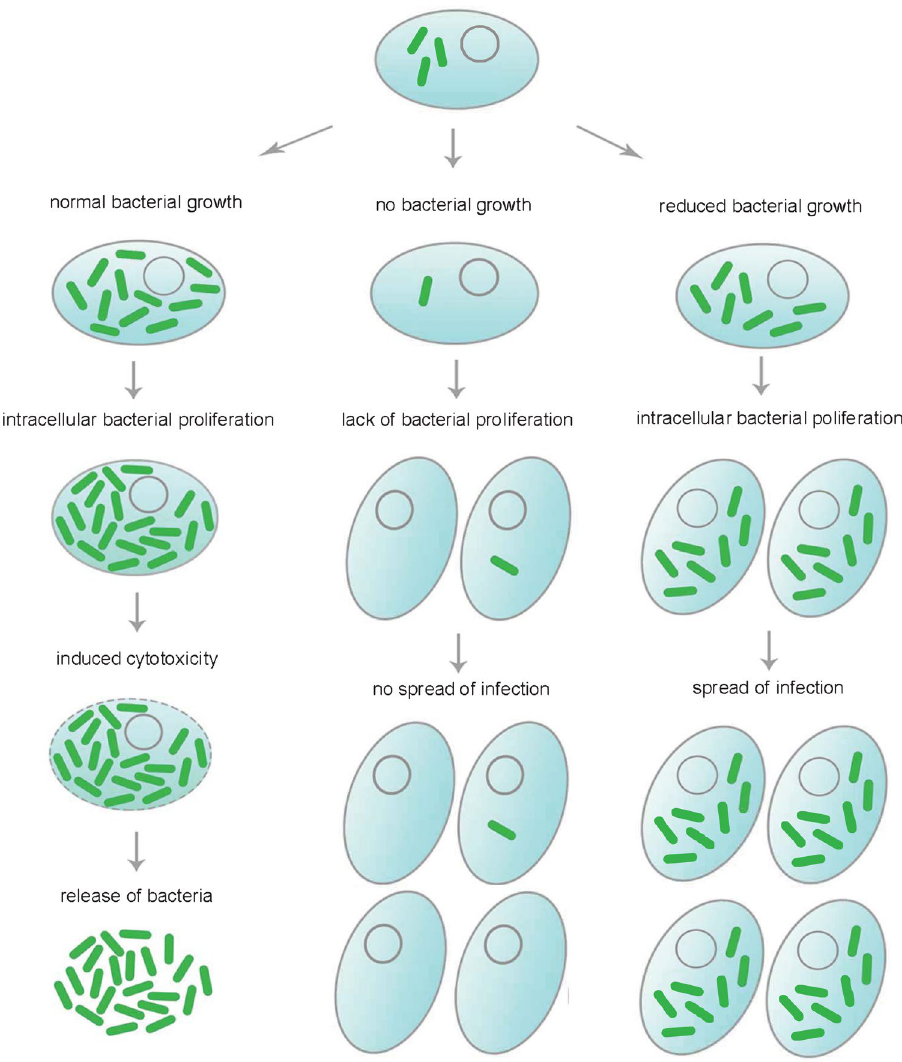
Figure 6. Scenario for the pro-infective activity of some antibiotics. A compound with strong antibiotic activity simply kills bacteria inside the host and cures the infection, resulting in a rapid leveling of the total fluorescence intensity of GFP-expressing M. marinum . A compound that lacks anti-infective activity does not prevent intracellular mycobacterial growth, causing early proliferation of the bacteria and the death of the host. The bacteria kill their growth niche and thus loose access to host resources, which together with the extracellular activity of amikacin limits the maximal fluorescence increase. Counterintuitively, a compound with mild anti-infective activity will decrease the fitness and virulence of intracellular M. marinum , thereby limiting its cytotoxicity towards the host cell. The bacteria thus proliferate, use cellular resources and spread the infection without killing the host, reaching potentially higher maximal